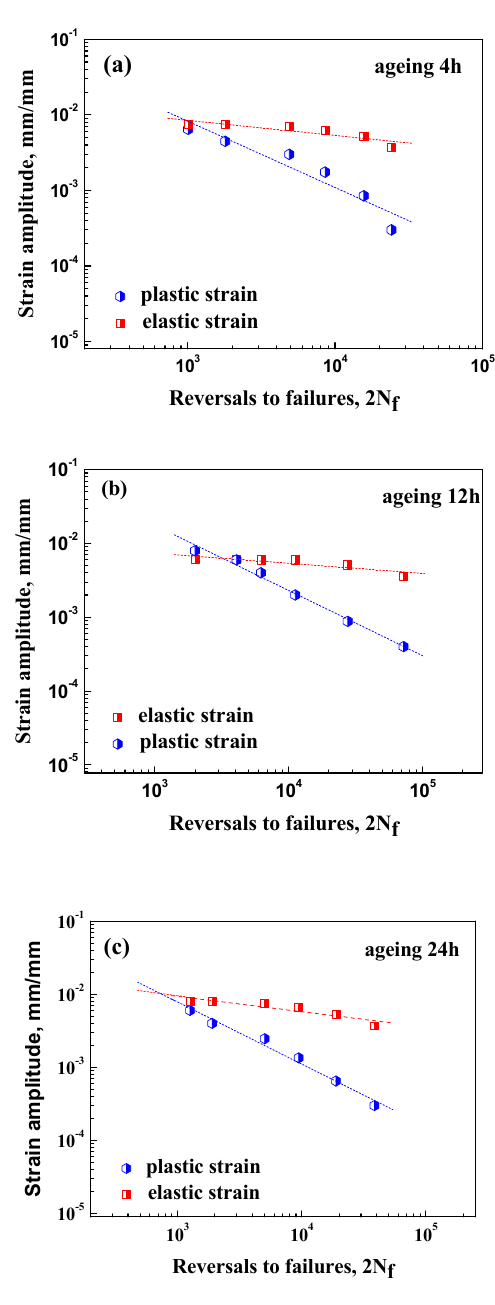
Figure 2. Strain amplitude versus reversals to failure curves for Ti-3Al-8V-6Cr-4Mo-4Zr alloys in different state. ( a ) aging after 4 h, ( b ) aging after 12 h, ( c ) aging after 24